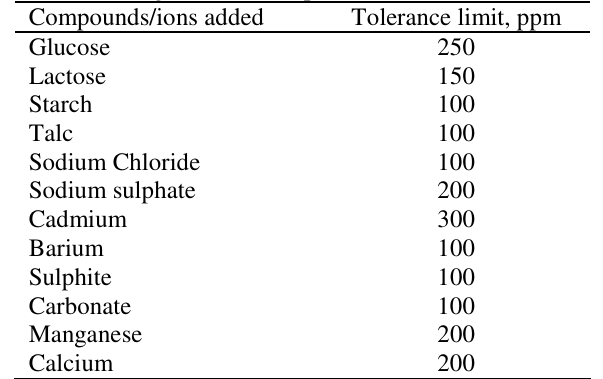
Table 2. Effect of interfering ions and excipients on the determination of paracetamol Compounds/ions